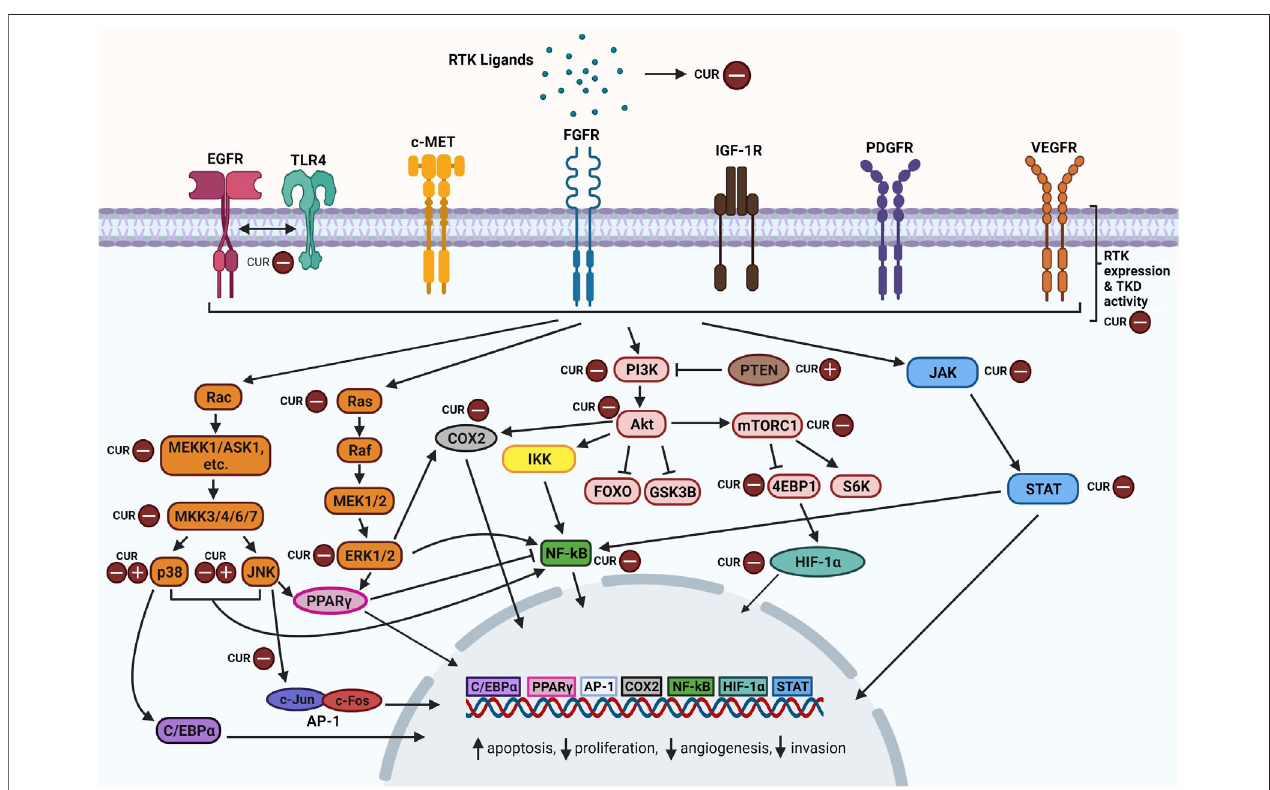
FIGURE 2 | Overview of curcumin-inhibition of RTKs and downstream MAPK, PI3K/Akt, JAK/STAT, and NF- κ B pathway components. Abbreviations: RTK: Receptor tyrosine kinase; CUR: Curcumin, EGFR: Epidermal growth factor receptor, TLR4: Toll-like receptor 4, c-MET: Mesenchymal epithelial transition factor/ Hepatocyte growth factor receptor; FGFR: Fibroblast growth factor receptor; IGF-1R: The insulin-like growth factor 1 receptor; PDGFR: Platelet-derived growth factor receptor; VEGFR: Vascular endothelial growth factor receptor; TKD: Tyrosine kinase domain; Rac: Ras-related C3 botulinum toxin substrate; ASK1: Apoptosis signal-regulating kinase 1; C/EBP α : CCAAT/enhancer-binding protein alpha; JNK: c-Jun N-terminal kinases; AP-1: Activator protein 1; Ras: Rat sarcoma virus protein; Raf: Rapidly accelerated fi brosarcoma protein; MEK: Mitogen-activated protein kinase kinase; ERK: Extracellular signal-regulated kinase; PPAR γ : Peroxisome proliferator-activatedreceptor γ ;COX2:Cyclooxygenase-2;PI3K:Phosphoinositide3-kinase;PTEN:Phosphataseandtensinhomolog;Akt:Akstraintransforming;IKK: Inhibitor of nuclear factor kappa B kinase; NF- κ B: nuclear factor kappa-light-chain-enhancer of activated B cells; FOXO: Forkhead box transcription factors; GSK3B: Glycogen synthase kinase 3 beta; Mtorc1: Mechanistic target of rapamycin complex 1; 4EBP1: Eukaryotic translation initiation factor 4E (eIF4E)-binding protein 1; S6K: Ribosomal protein S6 kinase; HIF- α : Hypoxia-inducible factor alpha; JAK: Janus kinase; STAT: Signal transducer and activator of transcription. Created with